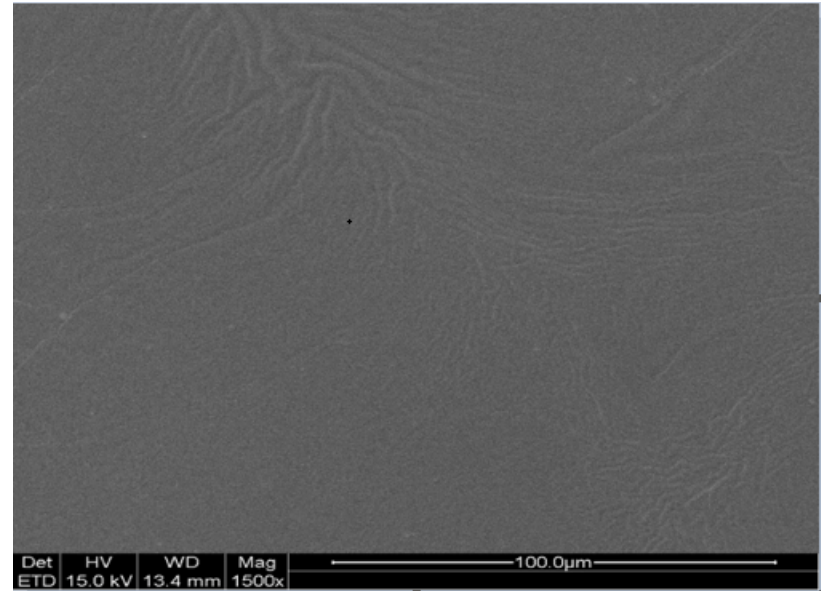
Figure 4. SEM images of the LP-VPH compound transdermal drug delivery system.